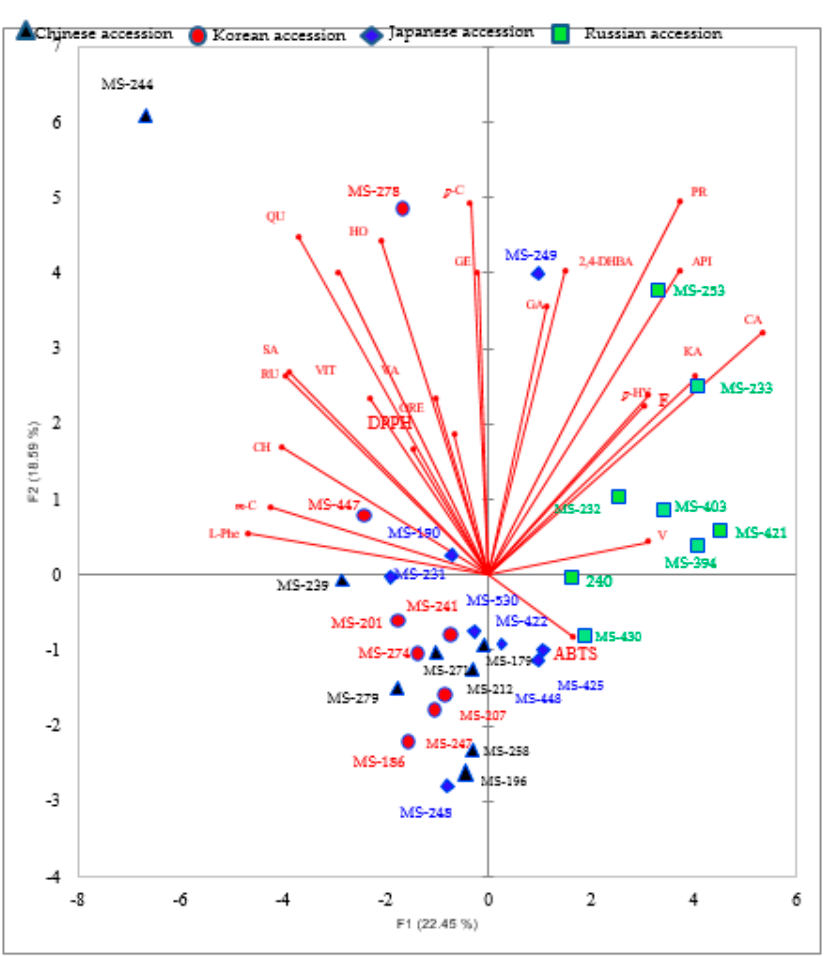
Figure 4. Principal composition analysis (PCA) biplot constructed by plotting the PC1 (vertical axis) scores against the PC2 (horizontal axis) scores obtained from phenolic compounds and antioxidant activity.